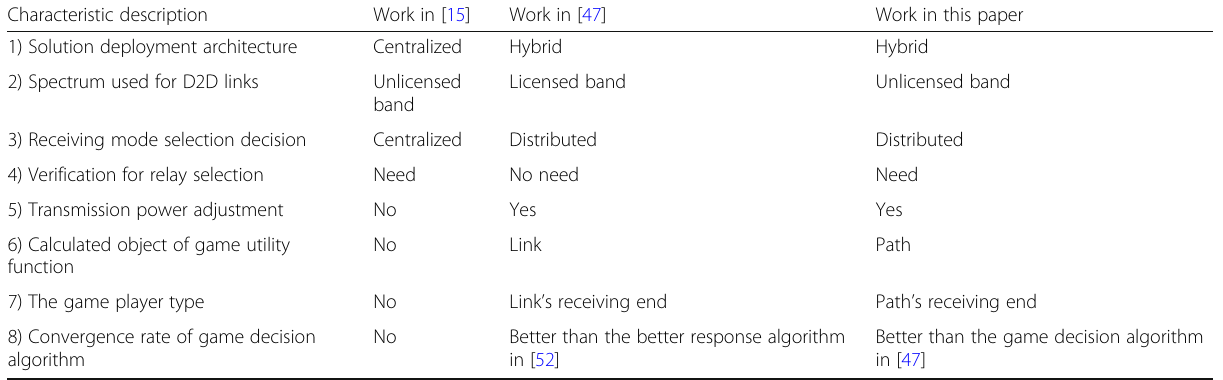
Table 2 The comparison of the characteristics of the three works Characteristic